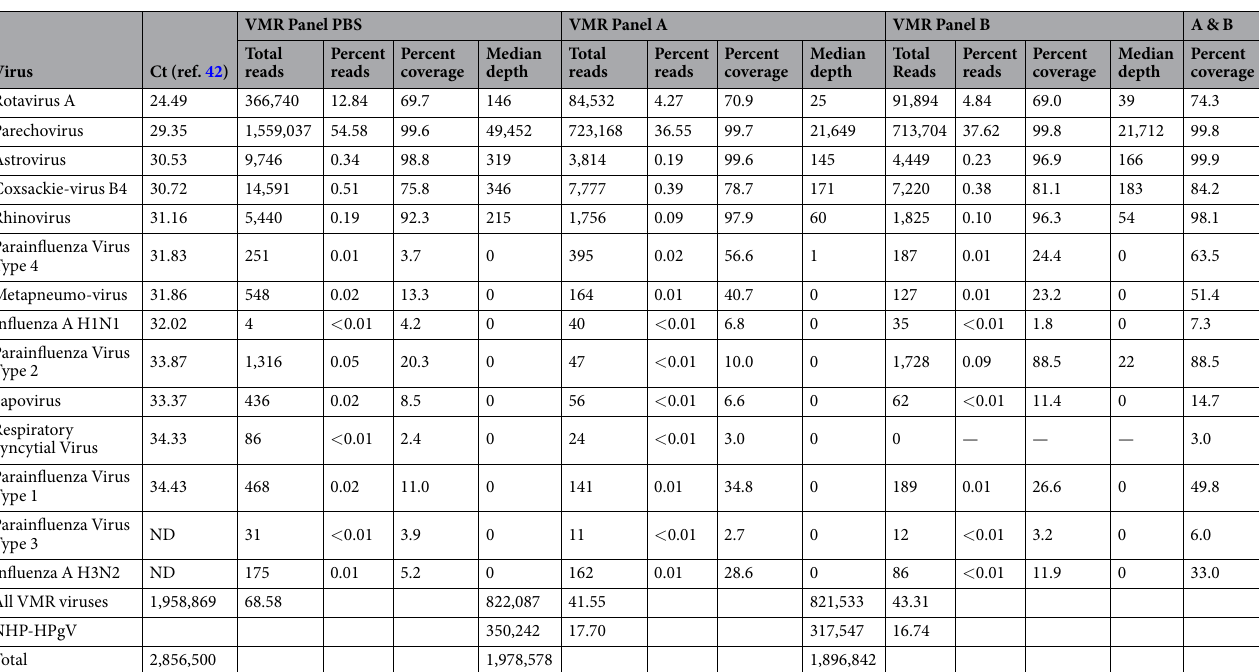
Table 4. Detailed sequencing data from the VMR Panel. For each of the three samples (PBS, A and B), the number and percentage of reads mapping to each of the 14 viruses are given, genome coverages and median depths. The final column gives these last two metrics from the combined data sets of both the A and B samples. Included in the analysis of samples A & B are data for the HPgV discovered in the sample